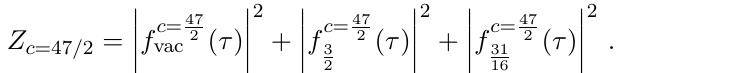
Therefore, it is natural to expect that the corresponding CFT with c = 47 (cid:1) = 3 has the Baby Monster symmetry. To support this hypothesis further, t